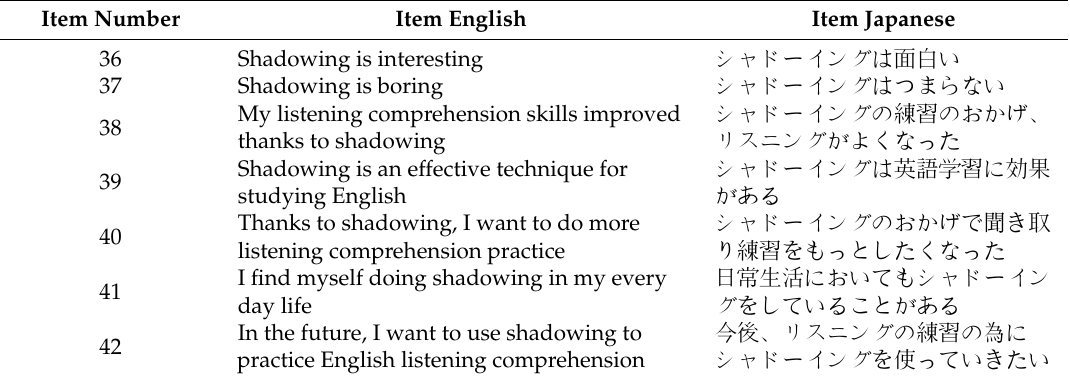
Table A9. Additional Post-Test Questions: Students’ Perceptions of the Utility of